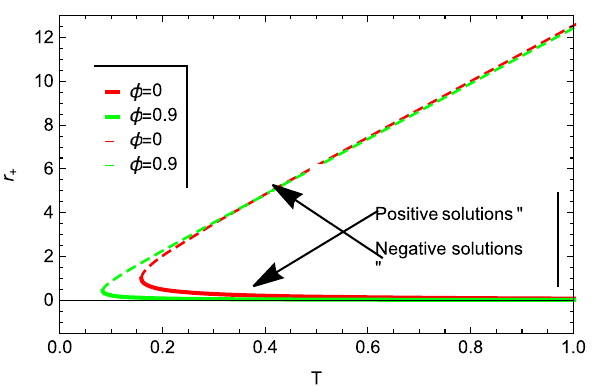
Fig. 11 Variation of the Gibbs free energy G w.r.t temperature T for (cid:20) = 0 . 9, ζ = 0 and P = 0 . 04